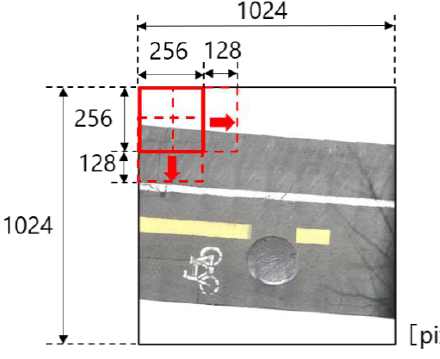
Figure 4. Creation of small segmented images.